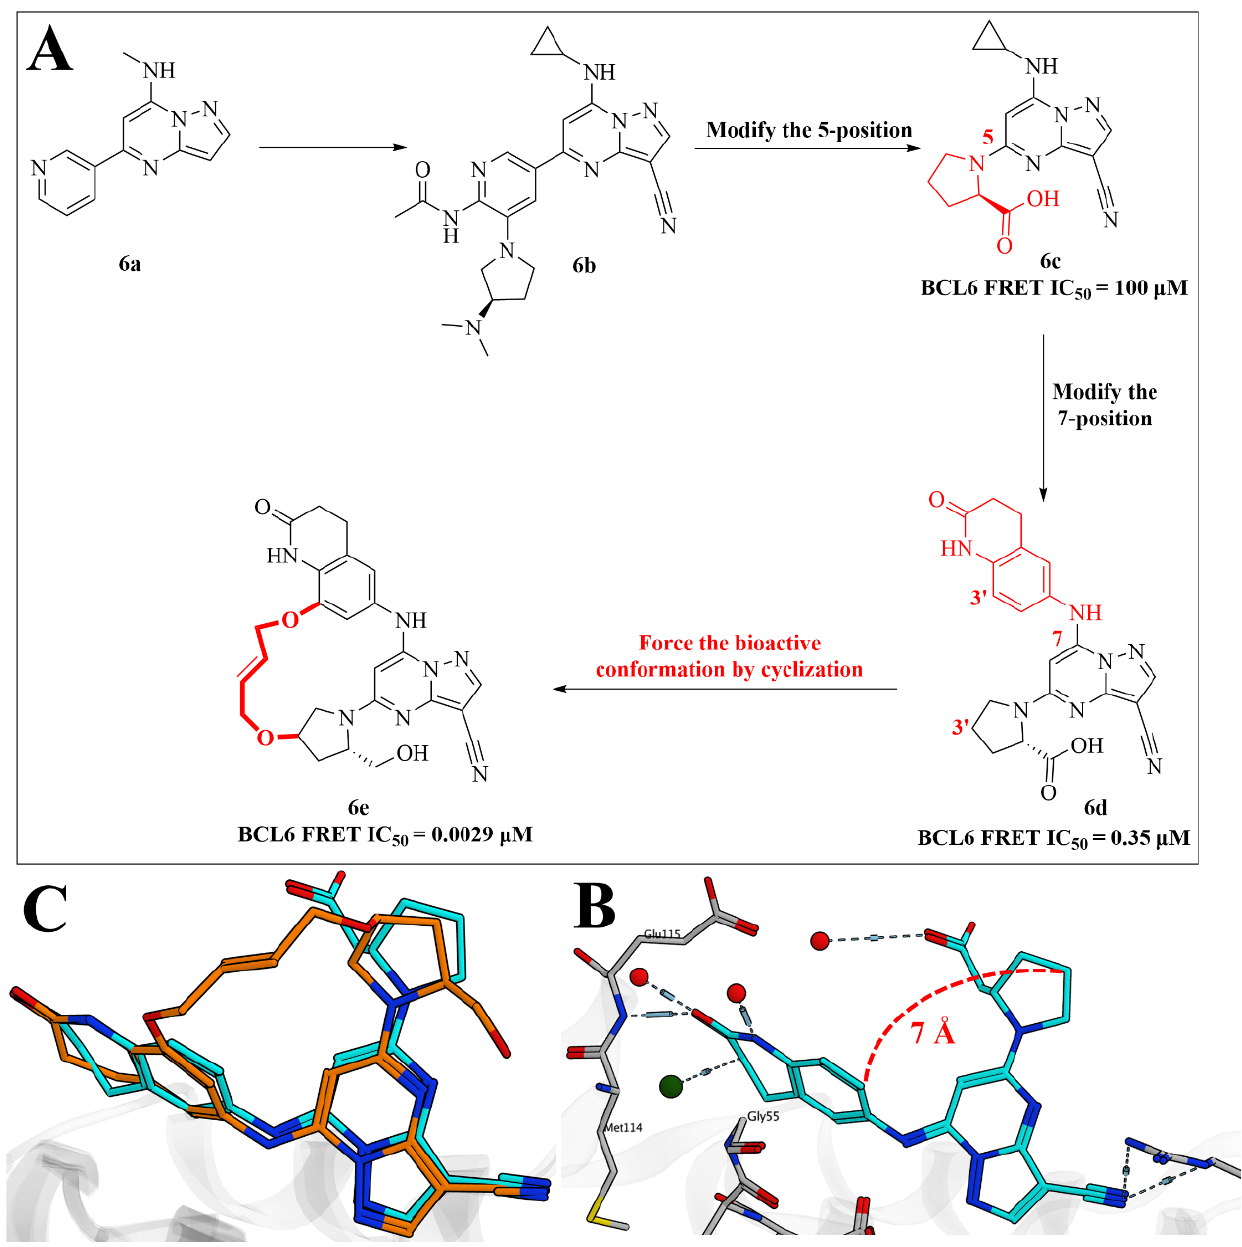
Figure 9. ( A ) Structural modification of BCL6 inhibitors. ( B ) Crystal structure of 6d (PDB: 5N21) in complex with BCL6 BTB domain homodimer. ( C ) Overlay of crystal structures of 6e (orange, PDB: 5N1Z) and 6d (cyan, PDB: 5N21) in complex with BCL6 BTB domain homodimer.